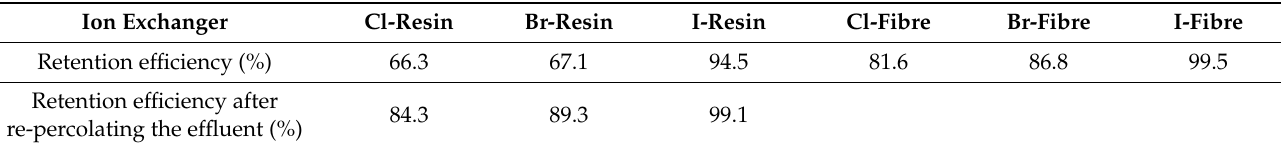
Table 3. Retention efficiency of Cd 2+ by X − -loaded resin and fibre. Ion Exchanger